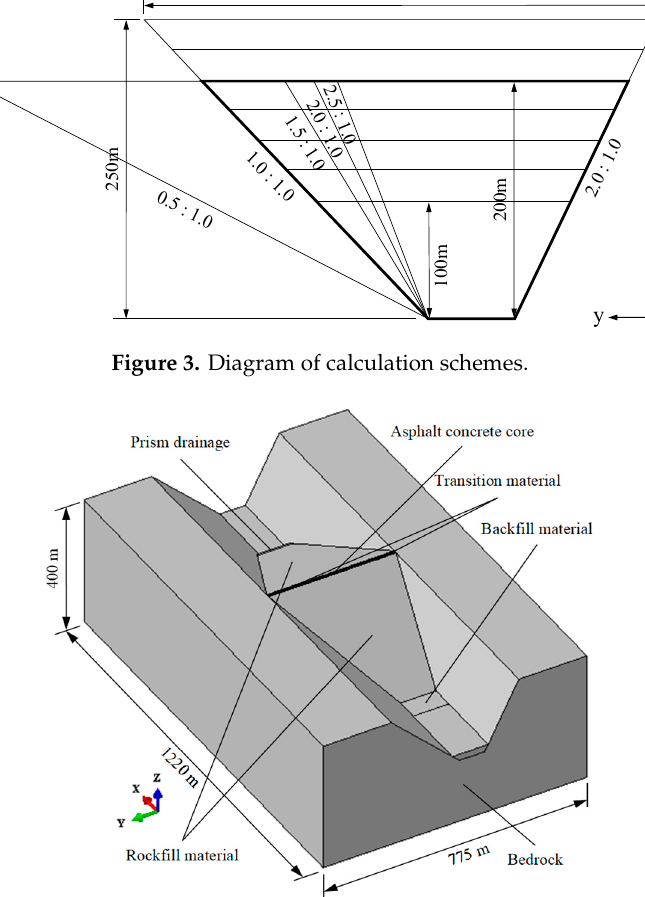
Figure 4. Material regions of finite element method (FEM) standard model for asphalt concrete core rockfill dams (ACCRDs).